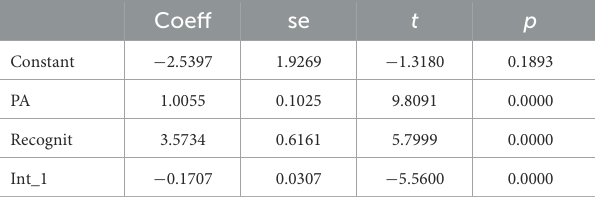
TABLE 8 Genuine acting and personal accomplishment, with recognition as the moderator.